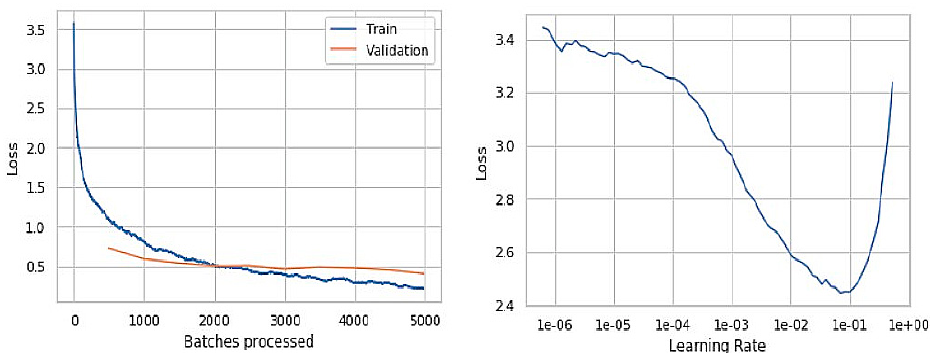
Figure 8. The training, validation, and learning rate of the final